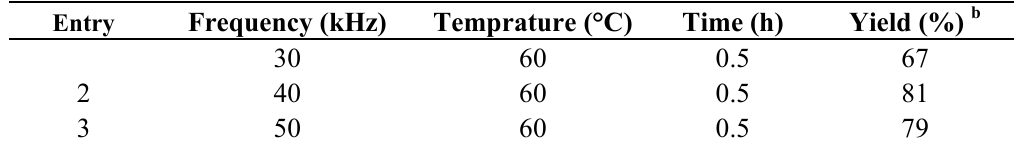
Table 2. The synthesis of 4a under ultrasound irradiation in various frequency a . Entry Frequency (kHz) Temprature